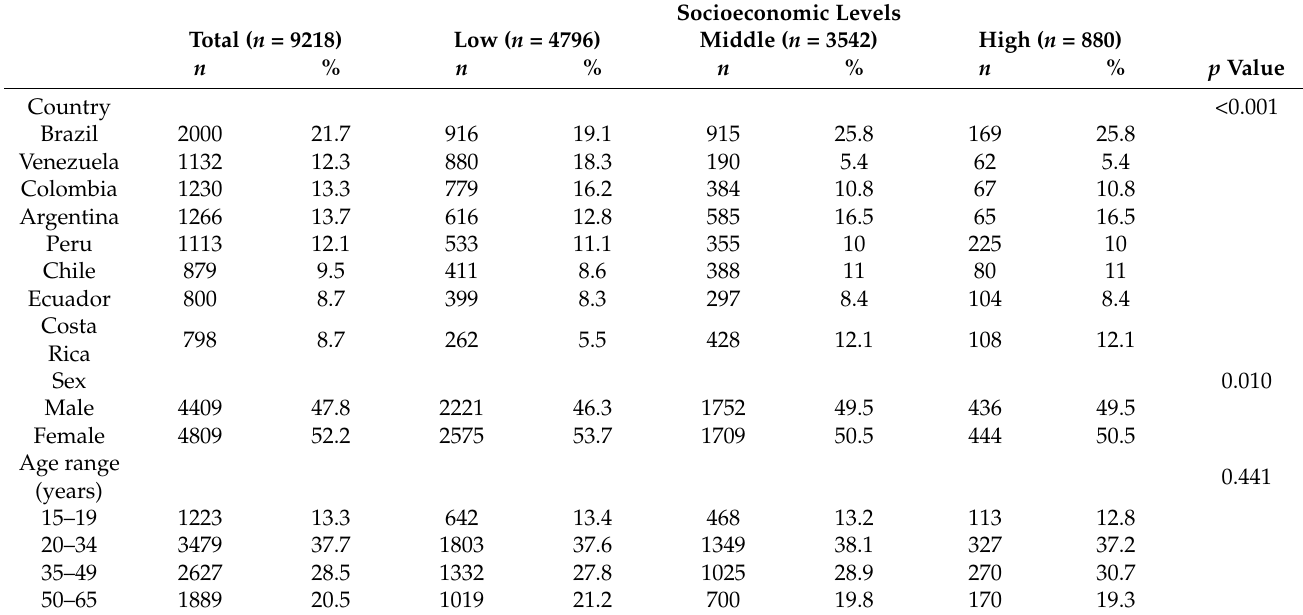
Table 1. Distribution of sociodemographic variables among the socioeconomic status—the Latin American Health and Nutrition Study